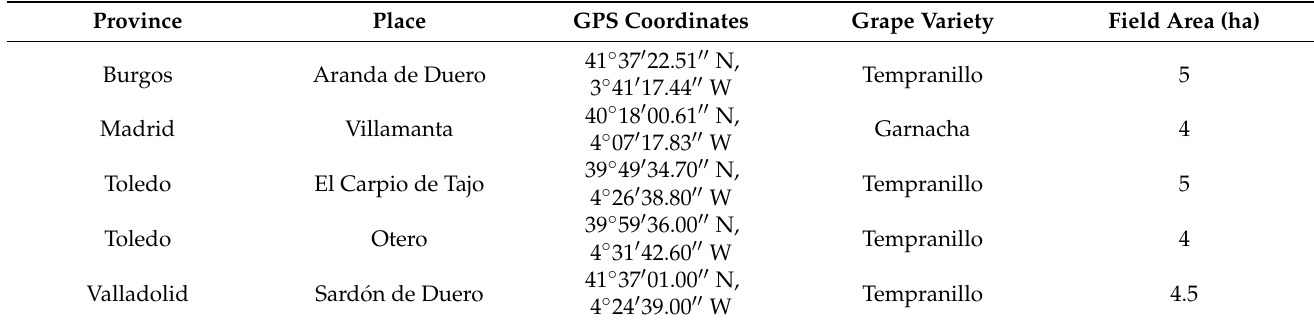
Table 1. Farm location and GPS